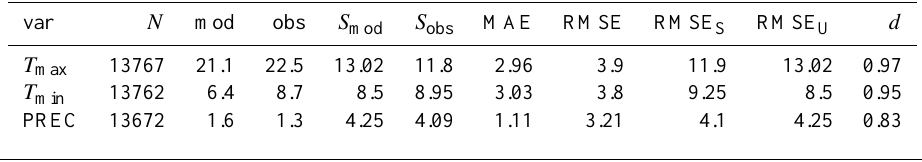
Table 1. Statistics describing the strength of the relationship between three meteorological forcing variables measured at a single site (located at 37.96 ◦ N and 39.63 ◦ E) and extracted from the NCEP dataset for the same location. The metrics used in comparison and their description and formulas are also provided.